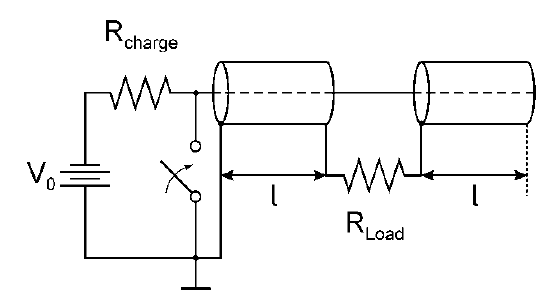
Figure 1. Generic circuit diagram of a Blumlein pulse generator. The two coaxial cables of identical length, l, are charged through a resistor, R discharged by closing a switch, into the load, R impedance of the